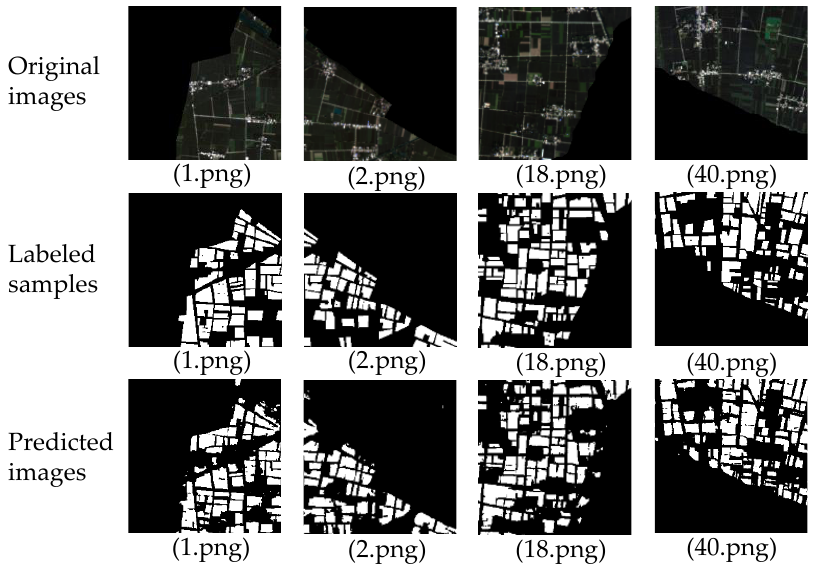
× 256 px cropping size.